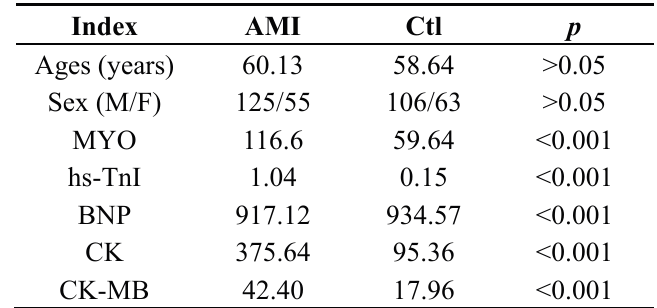
Table 1. Clinical and biochemical characteristics of the study population.